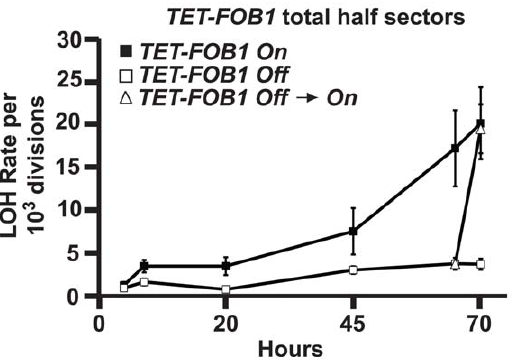
Figure 4. An inducible allele of FOB1 reveals the accumulation of aging factors in the absence of Fob1. Total MET15 LOH rates in aging UCC8912 cells exposed to no doxycycline ( FOB1 On; filled squares) or 20 m g/mL doxycycline ( FOB1 Off; open squares). At 65 hours, a portion of the Fob1 Off culture was harvested and transferred to media with no doxycycline ( FOB1 Off R On; triangles).